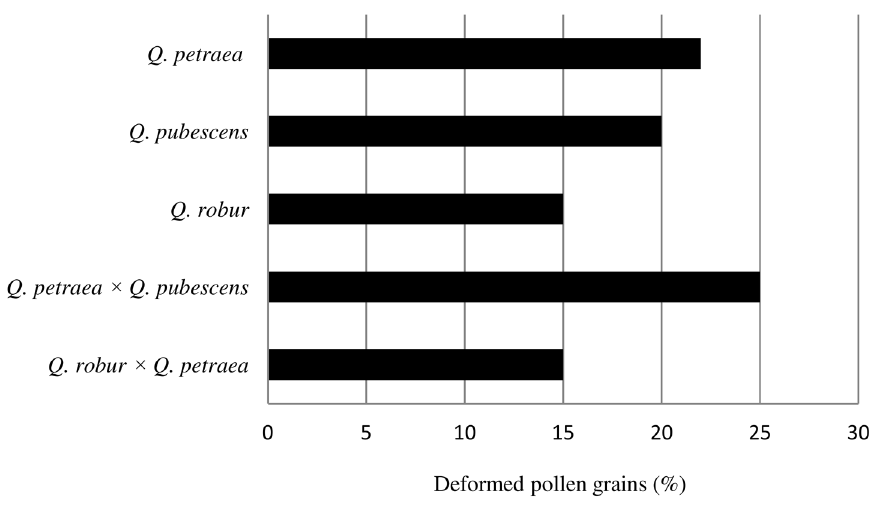
Fig 3. Percentage of deformed pollen